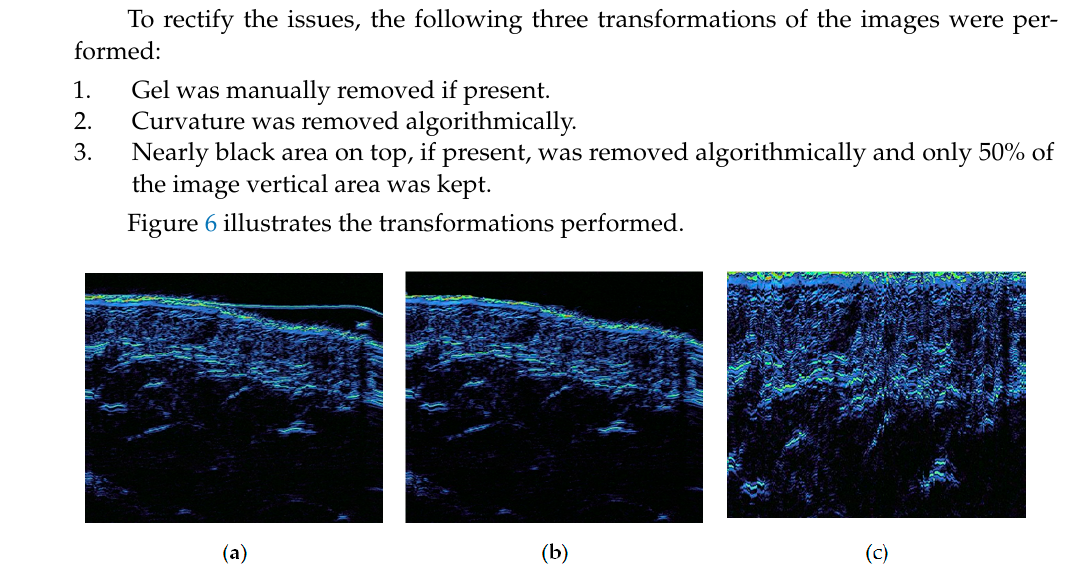
Figure 6. The ultrasound skin image and its transformations. ( a ) Original image, ( b ) gel layer removed, ( c ) curvature removed (+50% vertical cull).